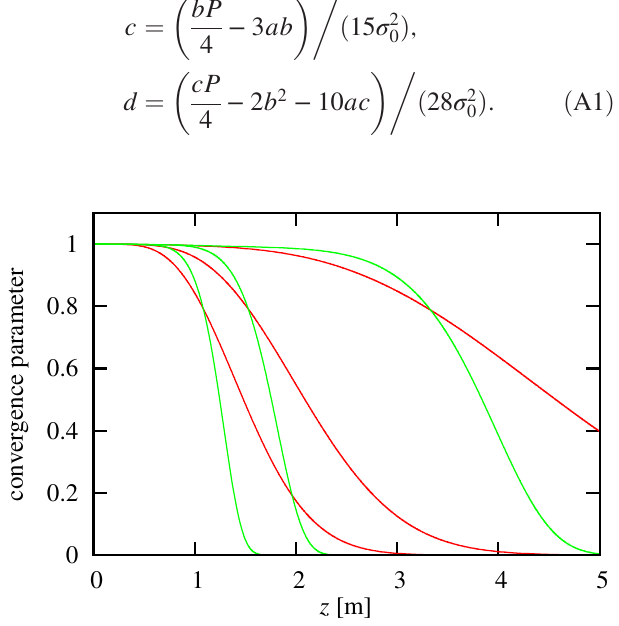
FIG. 19. Development of the convergence parameter Eq. (A3) of the polynomial series in a drift. Fourth-order approximation (red curves) and eighth-order approximation (green curves).